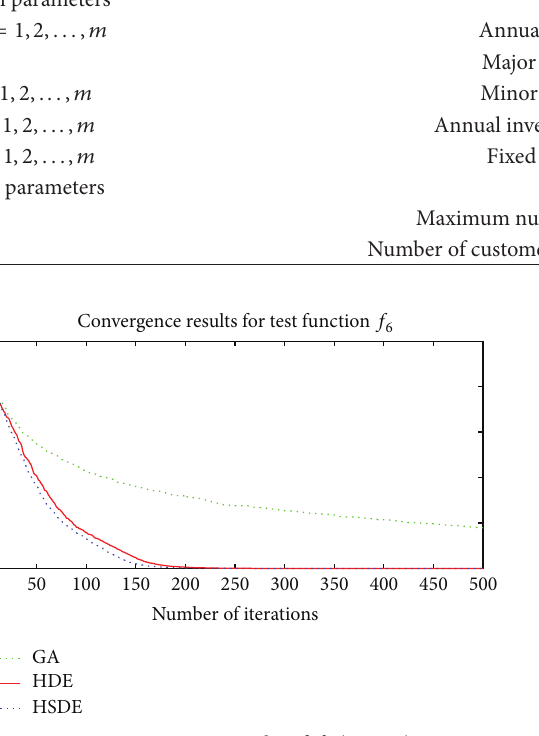
Figure 7: Convergence results of 𝑓 6 ( 𝐿 = 30 ).